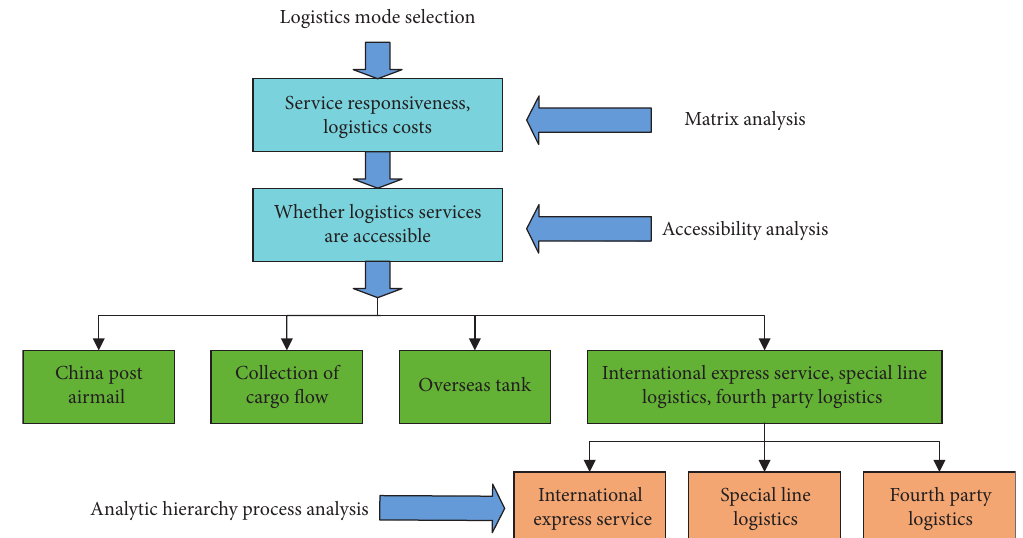
Figure 1: Logistics mode selection process of company A.